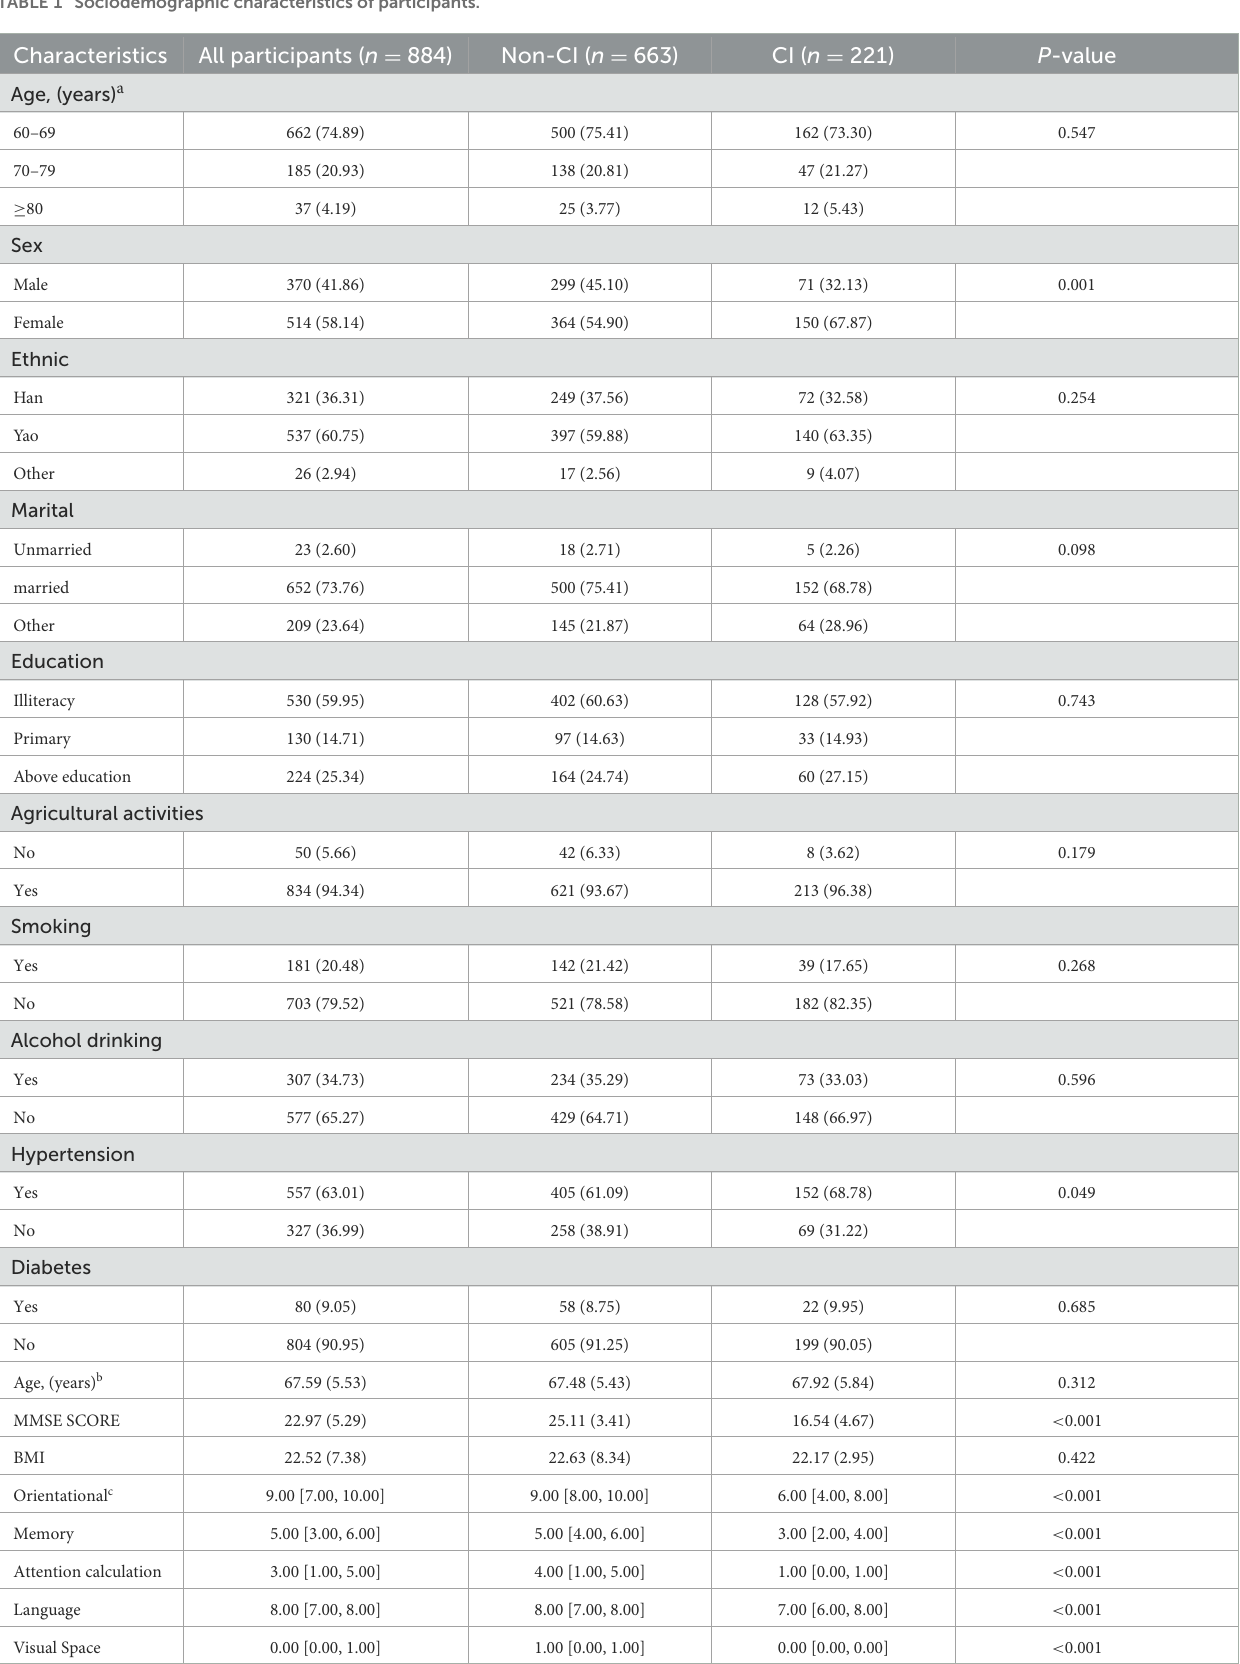
TABLE 1 Sociodemographic characteristics of